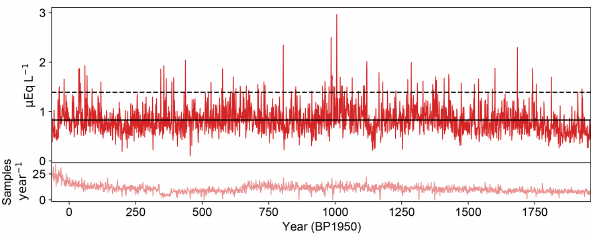
Figure 15. Time series for DJFM (summer) annual sea salts con- centration. Solid black line indicates the 2000-year mean value. Dashed black line indicates ± 2 σ